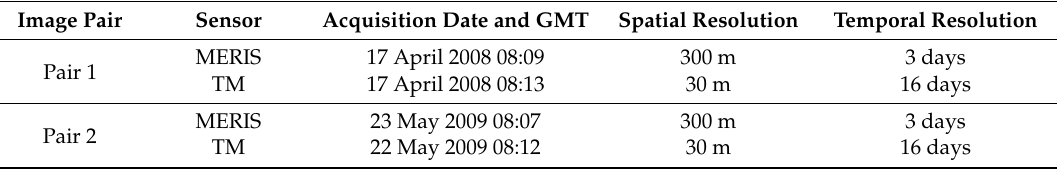
Table 1. A summary of EO data used in this study.